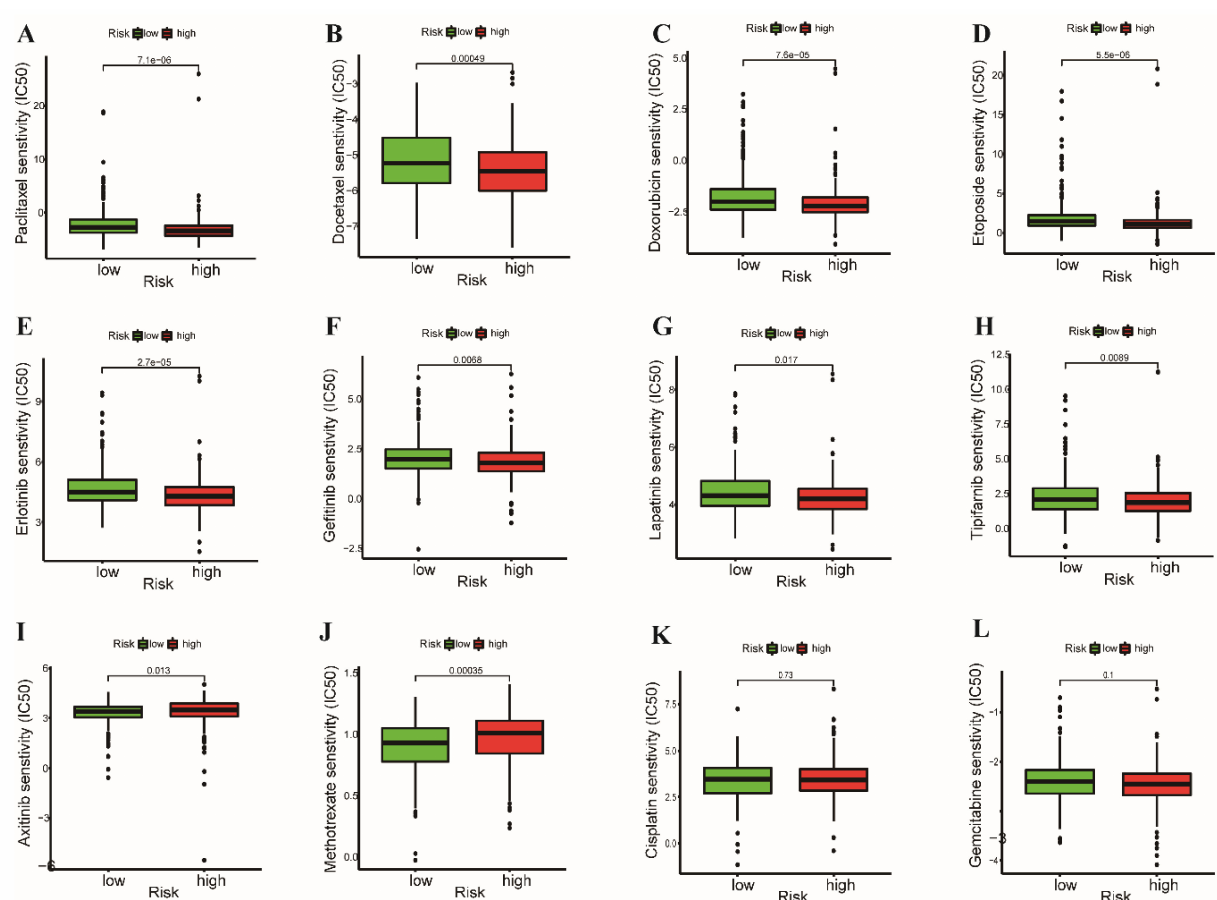
Figure 9. Prediction of the drug sensitivity (IC 50 ) of ( A ) paclitaxel, ( B ) docetaxel, ( C ) doxorubicin, ( D ) etoposide, ( E ) erlotinib, ( F ) gefitinib, ( G ) lapatinib, ( H ) tipifarnib, ( I ) axitinib, ( J ) methotrexate, ( K ) cisplatin, and ( L ) gemcitabine. p < 0.05 is considered statistically significant. (7.1e − 06 = 7.1 × 10 − 6